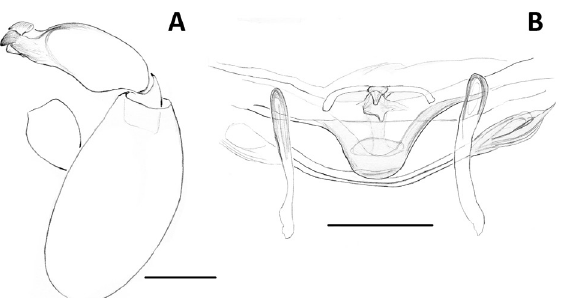
Figure 10. Opopaea spinosiscorona n. sp., from Kurulukelle FR: A , male left palp, prolateral view; B , female epigastric re- gion, ventral view. Scale bars: 0.1